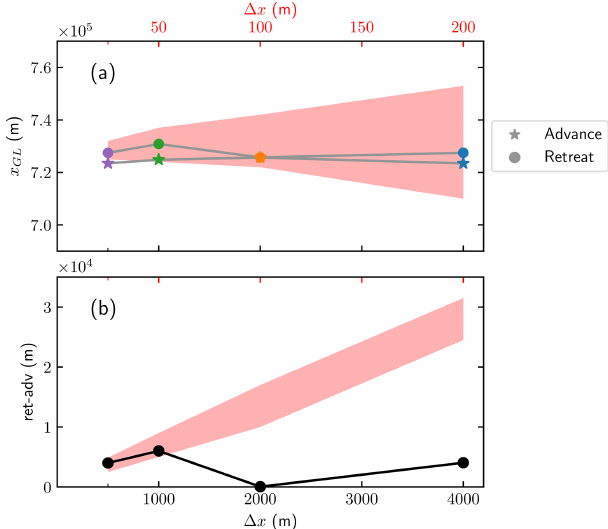
Figure 6. The MISMIP 3a experiments at the final time t = 10000 with the resolutions at (cid:49)x = 4, 2, 1, and 0 . 5km. (a) The GL po- sitions in the advance (») and retreat ( • ) phases. (b) The distance between the retreat and the advance x GL at the steady states. The shaded regions indicate the range of the results in Gagliardini et al. (2016) with 20-times-smaller mesh resolutions from 25 to 200m, with the axis scale shown in red at the top of the